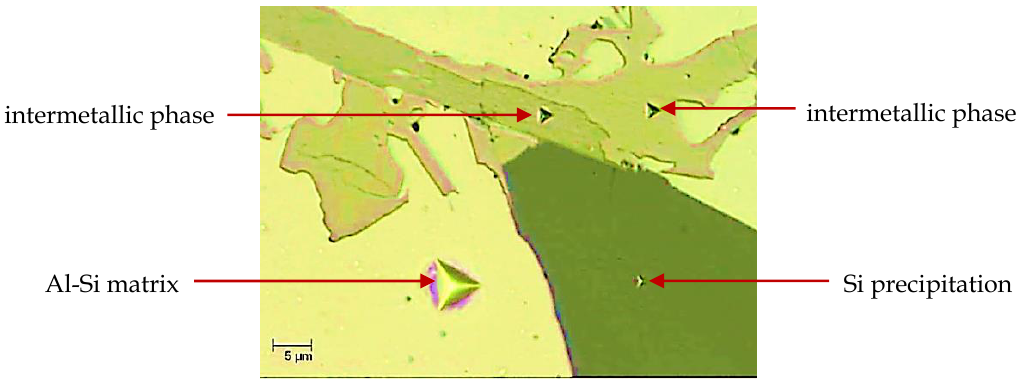
Figure 3. An example view of indents made in a silicon precipitation, in intermetallic phases, and in the matrix with the use of Nanoindentation Tester NHT (CSM Instruments).